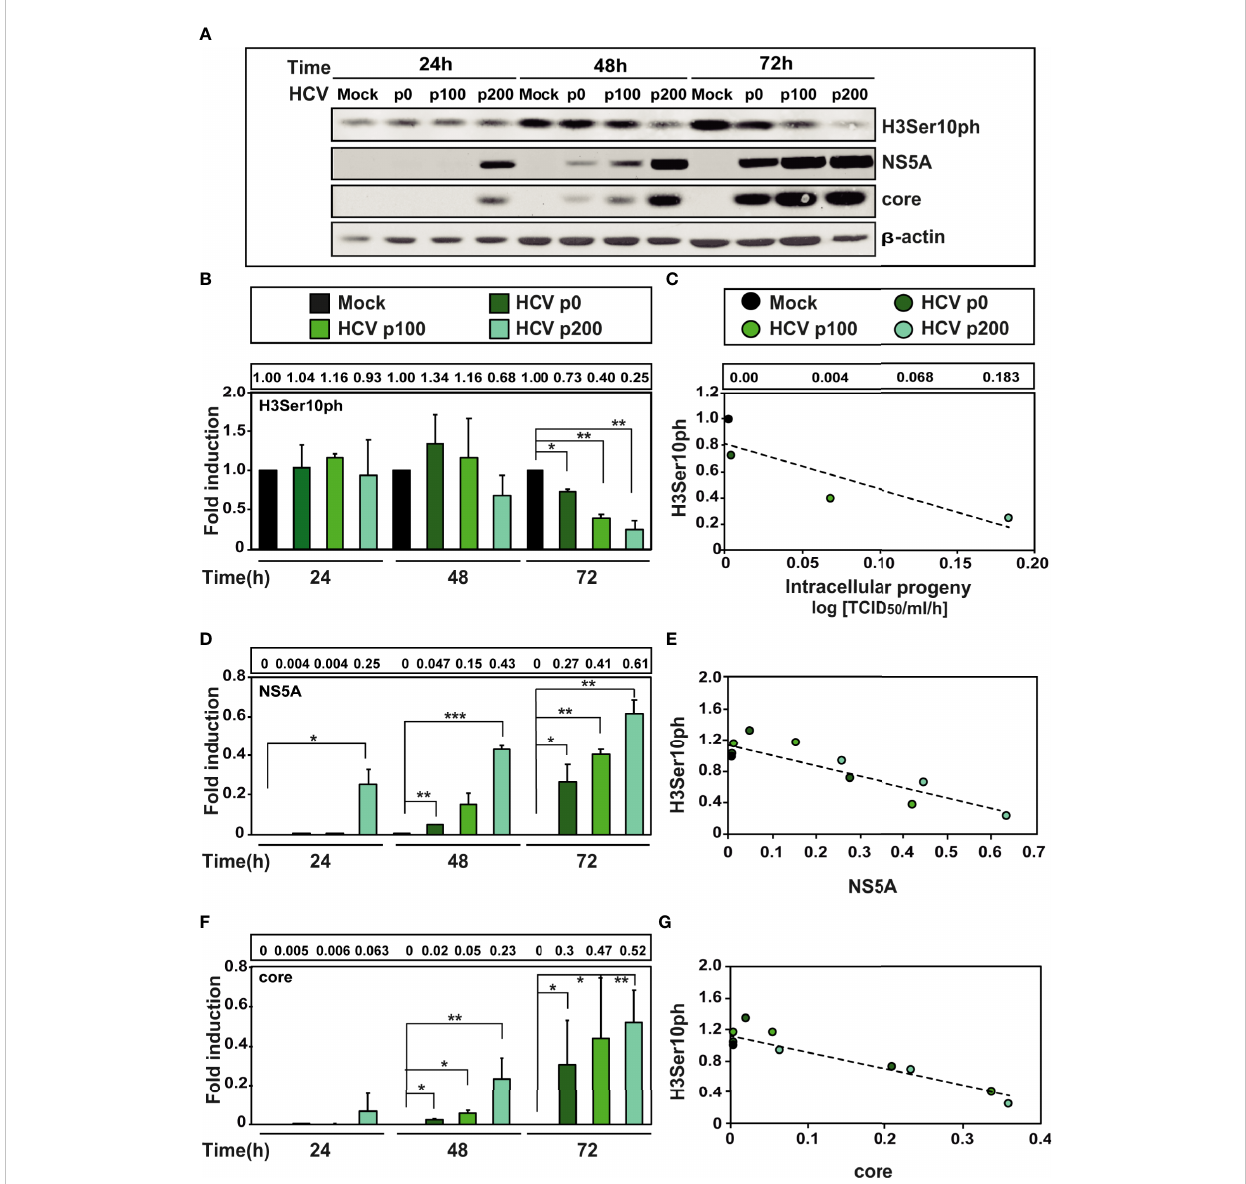
FIGURE 2 Effect of HCV fi tness on the level of cellular protein H3Ser10ph and viral proteins NS5A and core. (A) Huh-7.5 reporter cells were either mock- infected or infected with HCV p0, HCV p100 or HCV p200 (abbreviated as p0, p100 and p200, respectively) at an initial MOI of 0.03 TCID 50 /cell; protein extracts were prepared at the indicated times post-infection. Bands are those visualized by Western blot assays of cellular protein H3ser10ph and viral proteins NS5A and core (with b -actin as loading control). (B) H3Ser10ph levels in mock-infected or HCV-infected cells expressed as the fold induction relative to the corresponding value for the mock-infected cells; the infecting HCV (code in upper box), and the time post-infection at which extracts were prepared are given in the abscissa; the numerical densitometry values (measured relative to the mock-infected sample, taken as 1) are indicated in the upper box, next to the panel. Asterisks indicate statistical signi fi cance as follows: *p<0.05; **p<0,01; ***p<0.00; unpaired t- test. The values are the result of three independent experiments (biological triplicate). (C) Correlation between the increase of intracellular viral titer (code of infecting virus in upper box) expressed as log. 10 TCID 50 /ml/h [data are from (28) and they are indicated in the box above the panel, for mock, HCV p0, HCV p100 and HCV p200, respectively] and the relative H3Ser10ph densitometry values at time 72 hours post-infection (given in panel B). The discontinuous line corresponds to function y=-3.45x+0.81 (R 2 = 0.77, p-value=0.1227; linear regression test). (D) Same as B but for viral protein NS5A. (E) Same as C but for the correlation between viral protein NS5A and cellular protein H3Ser10ph levels (densitometry values in panels B and D). The discontinuous line corresponds to function y=-1.33x+1,13 (R 2 = 0.77; p-value=0.00018; linear regression test). (F) Same as B but for viral core protein. (G) Same as C but for the correlation between viral core protein and H3Ser10 levels (densitometry values in panels B and F). The discontinuous line corresponds to function y=-2.13x+1.12 (R 2 = 0.85; p-value=0.000018; linear regression